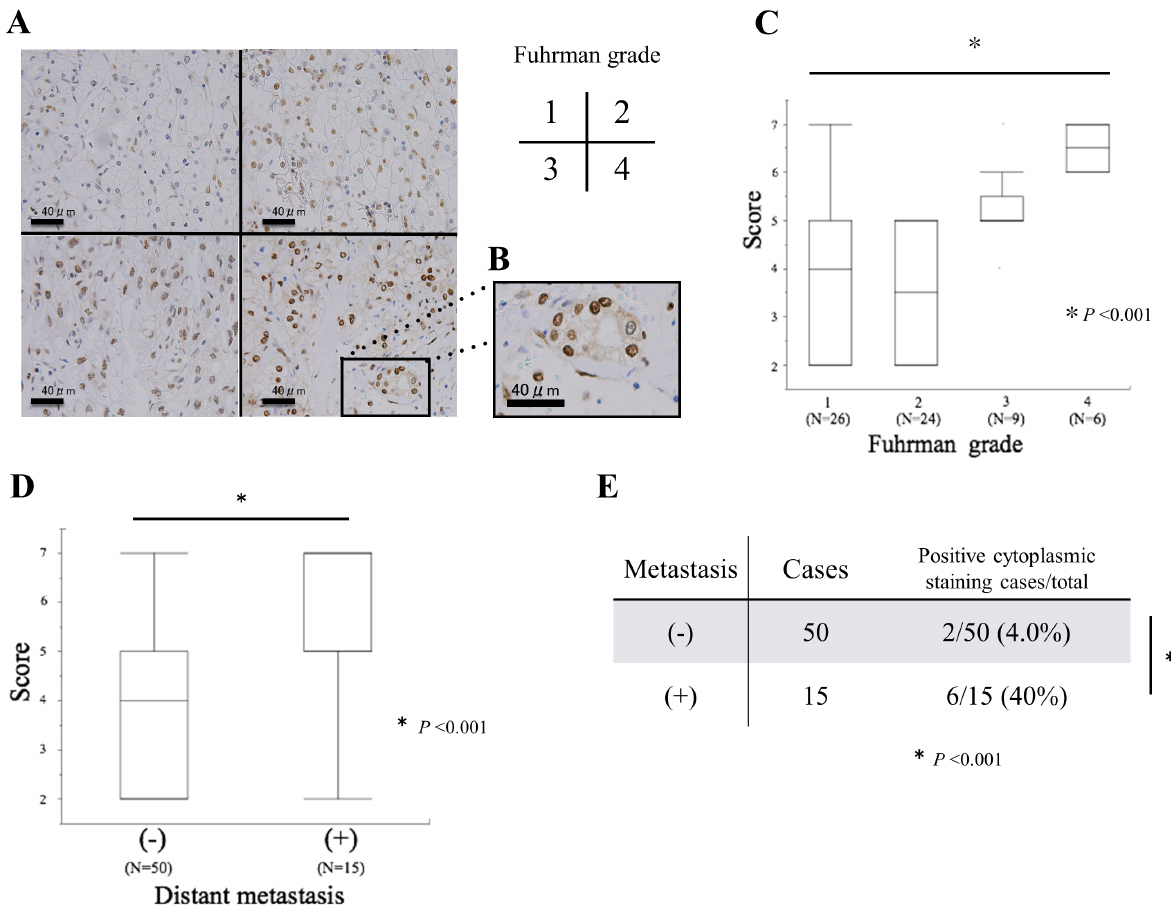
Fig 3. Correlation hnRNP K expression alterations with RCC aggressiveness in IHC analysis. A. Immunoreactivity of hnRNP K in clear cell type (cc) RCC Fuhrman grade 1, 2, 3, and 4; B. A part of the Fuhrman grade 4 micrograph is highly magnified in the right panel; C. Staining scores for hnRNP K in ccRCC tissues with diverse Fuhrman grades; D. Staining scores in primary ccRCC specimens with and without distant metastasis; E. Correlation between cytoplasmic staining and distant metastasis in these ccRCC specimens.